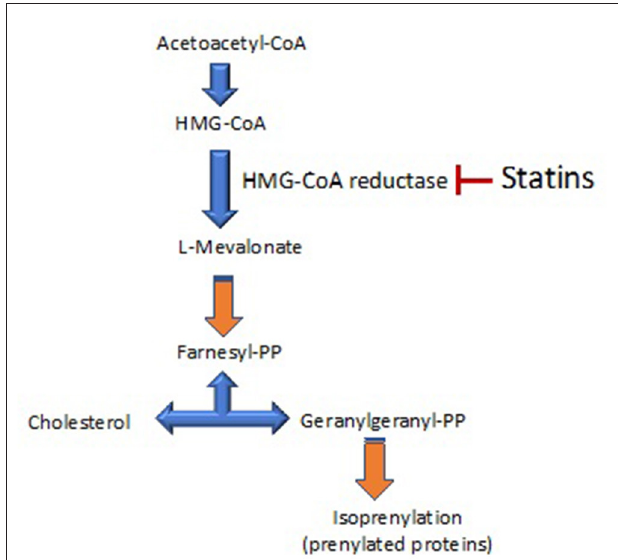
FIGURE 1 | A scheme of the cholesterol synthesis pathway. 3-hydroxy-3-methyl-glutaryl-coenzyme A reductase (HMG-CoA reductase) is the rate-controlling enzyme of the mevalonate pathway involved in cholesterol synthesis. This pathway also produces the biosynthesis of isoprenoids. The main target of statins is the inhibition of HMG-CoA